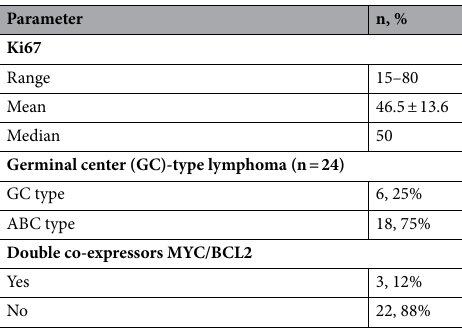
Table 1. Clinical and immunohistochemical features of the lymphomas studied. n = 25 unless otherwise specified.